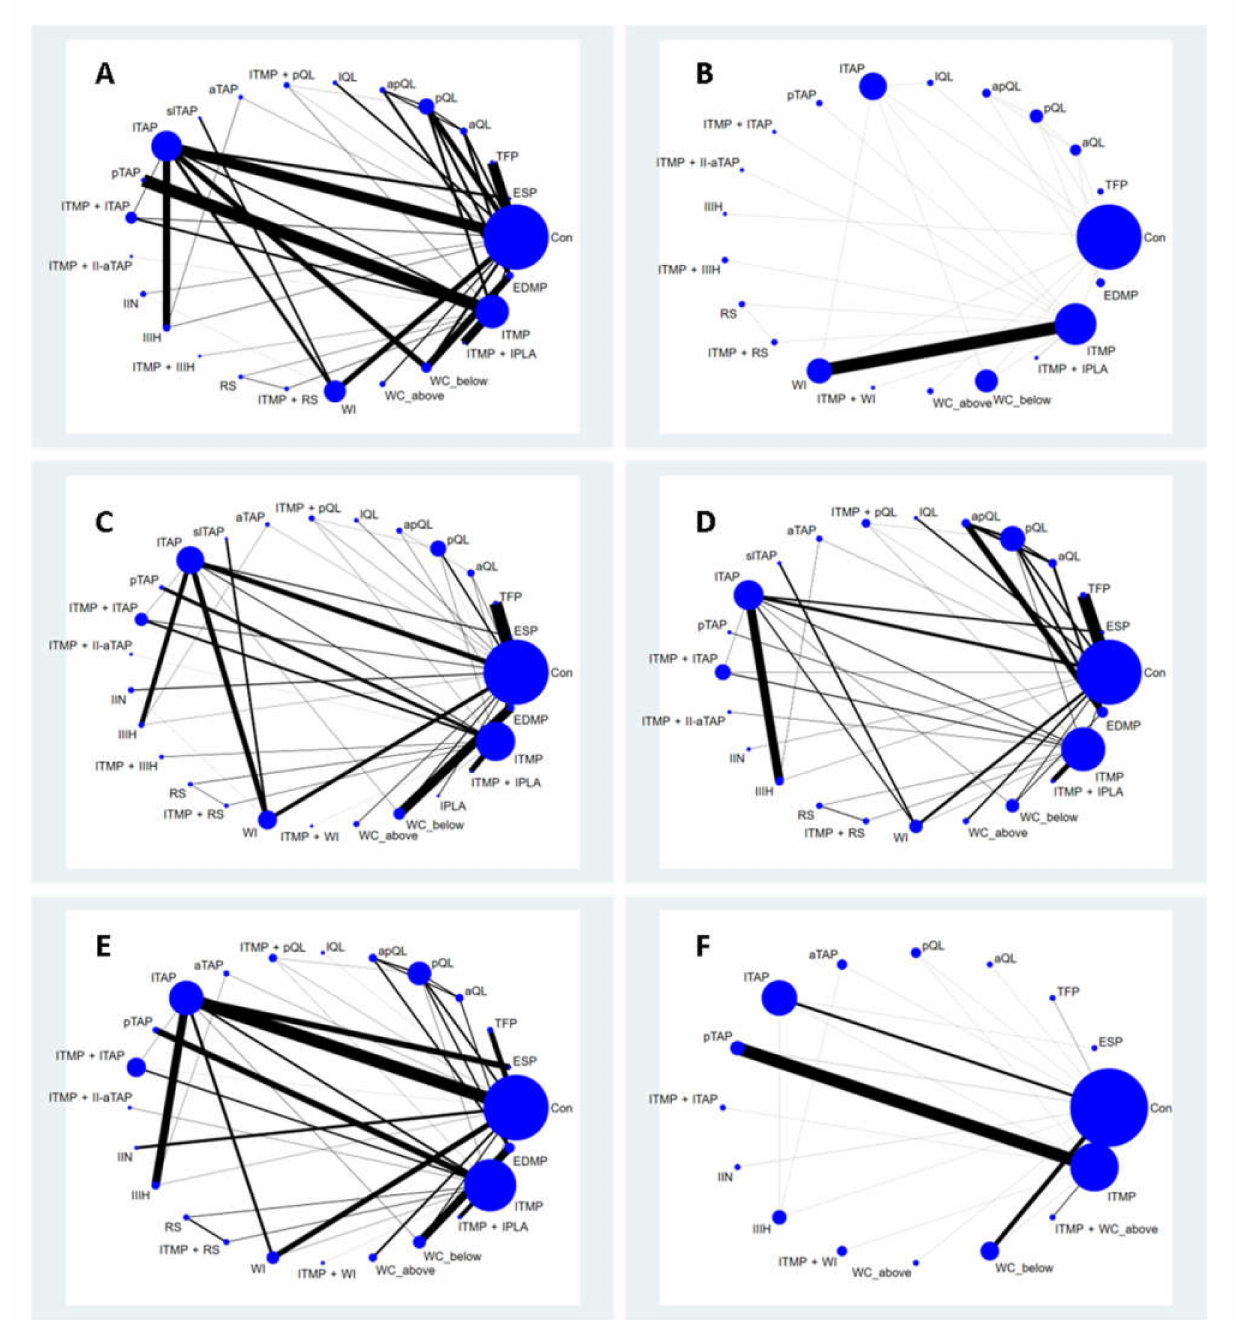
Figure 2. Network plots of direct comparisons for all included studies for outcomes. Each postopera- tive analgesia strategy is depicted by a node that is weighed based on the number of subjects who were randomized to that intervention. Edges between the nodes show the eligible direct comparisons among those interventions, and their width is weighed based on an inverse of the standard error of effect. ( A ) Pain at rest 6 h after surgery; ( B ) Postoperative cumulative 24 h morphine equivalent consumption; ( C ) Pain at rest 24 h after surgery; ( D ) Dynamic pain at 6 h after surgery; ( E ) Dynamic pain at 24 h after surgery; ( F ) The time to first analgesic